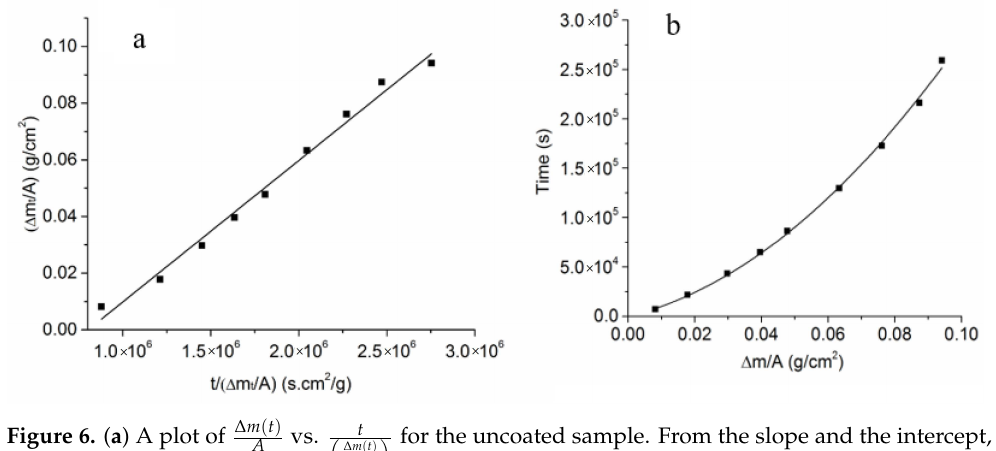
∆ m ( t ) Figure 6. ( a ) A plot of vs. t (cid:16) (cid:17) for the uncoated sample. From the slope and the intercept, ∆ m ( t ) A A ∆ m ( t ) both D ef f and k ef f can be determined. ( b ) A plot of t vs. for the uncoated sample by a second A order polynomial fitting with the intercept set as 0. From the 1st order and 2nd order coefficients, both k ef f and D ef f can be determined.